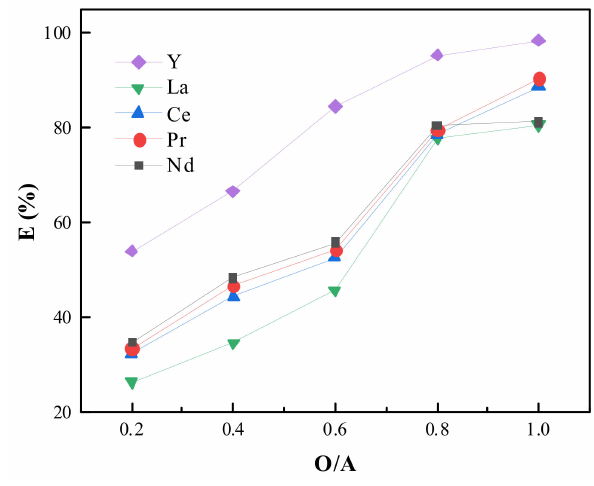
Figure 6. Effect of phase ratio on the extraction of REE.